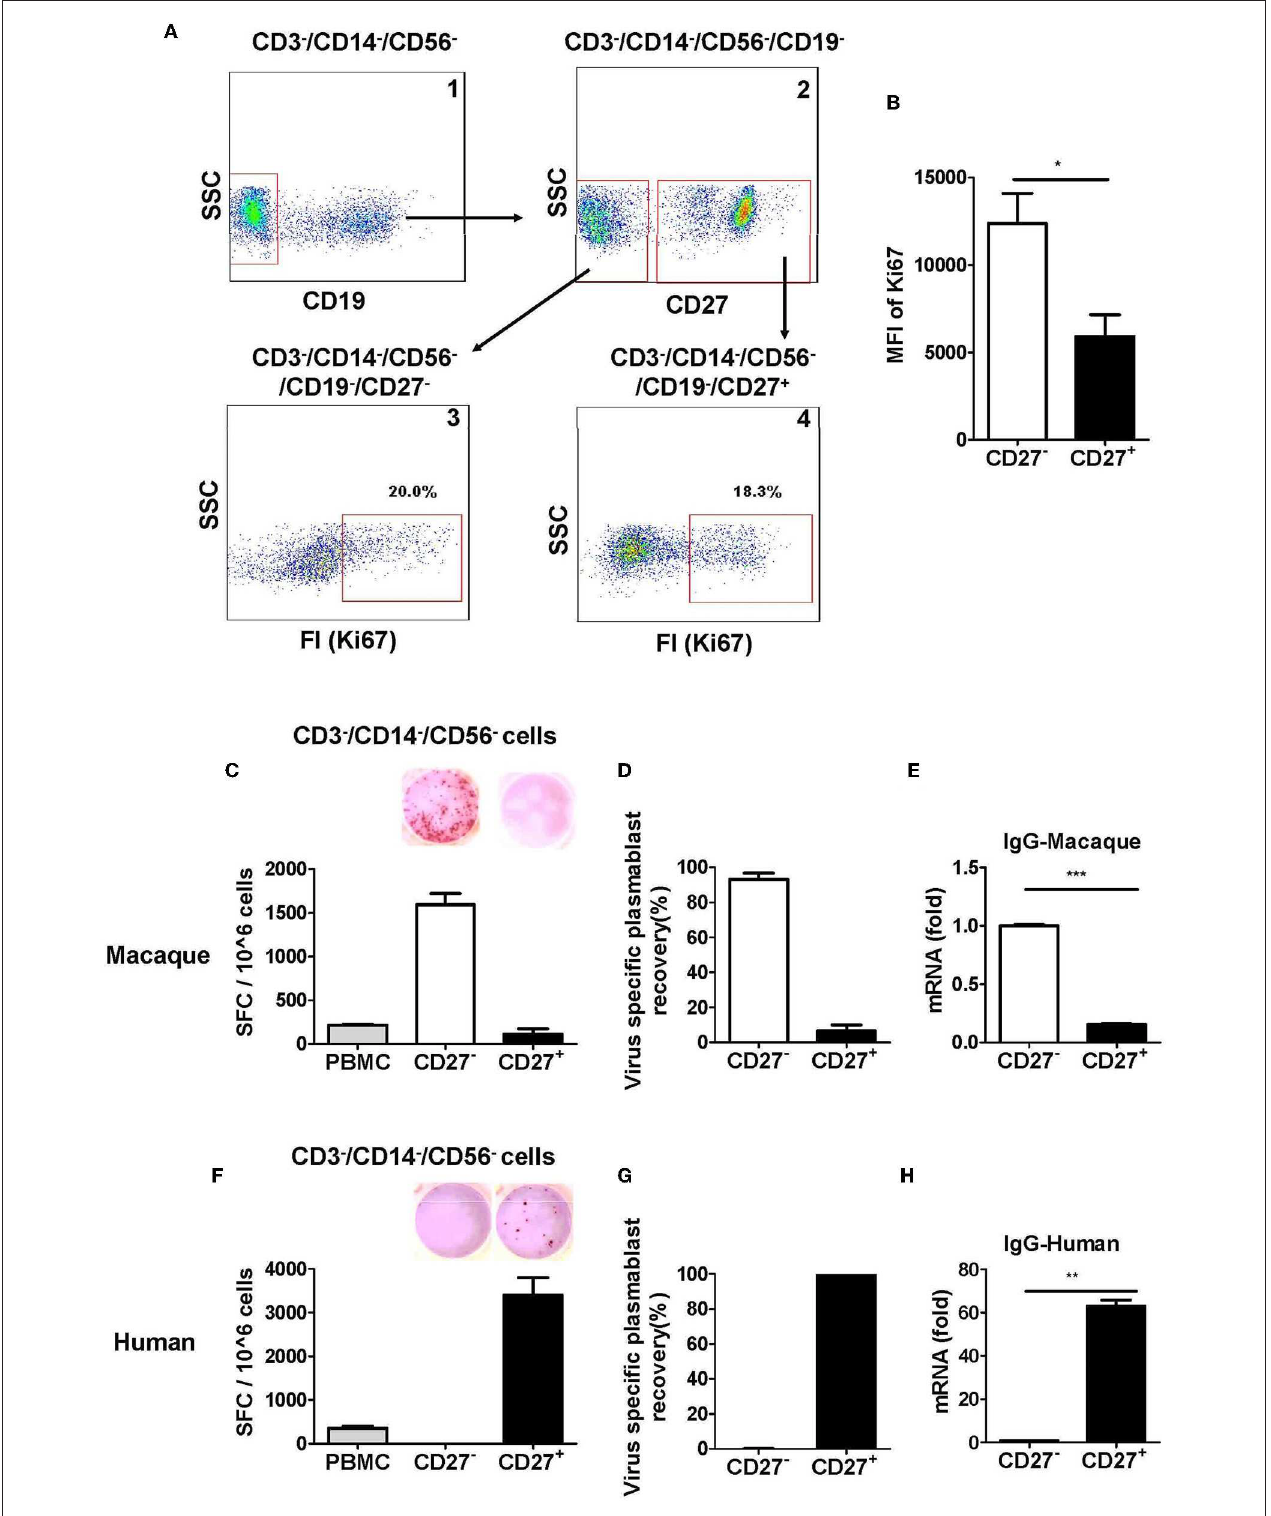
FIGURE 3 | Antibody-secreting plasmablasts from Chinese rhesus macaques are primarily Ki67 + CD19 − CD27 − cells. (A) Flow cytometry analysis showing intracellular expression of Ki67 + in CD27 − or CD27 + cells. (B) Mean fluorescence intensity (MFI) of Ki67 expression in CD3 − CD14 − CD56 − CD19 − CD27 − and CD3 − CD14 − CD56 − CD19 − CD27 + cells subsets. PBMCs from rhesus macaques (C,E) ( n = 4) and human volunteers (F,H) ( n = 3) were sorted from among the